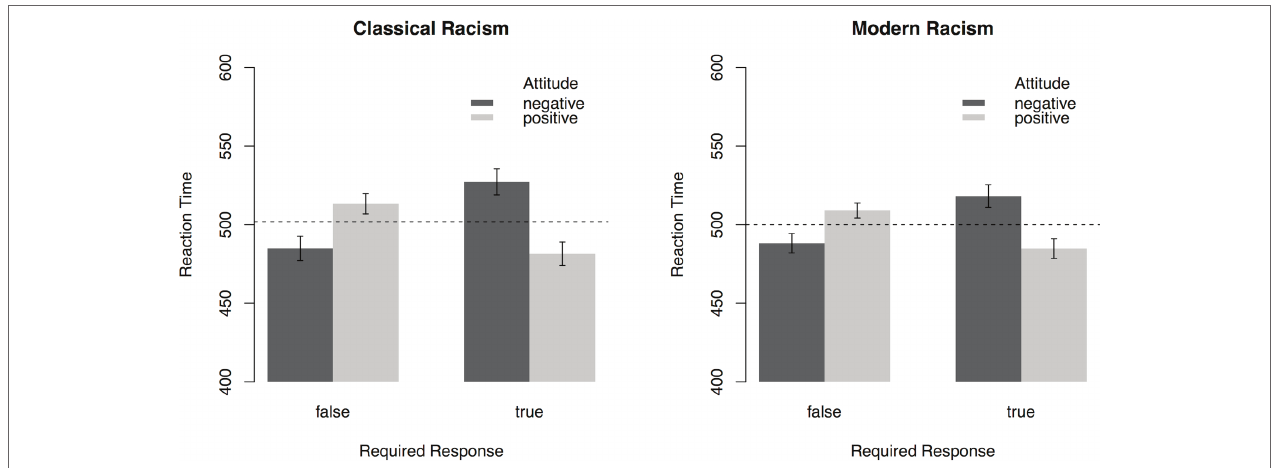
FIGURE 2 | Reaction times (error bars indicate 95% CI) in the PEP depending on Attitude toward refugees expressed in the sentences, Required Response , and the type of Scale (Experiment 1). Dashed lines represent mean reaction time. On the sample level, results indicate that participants associate positive attitudes more strongly with “true” responses, with the reverse being true for negative